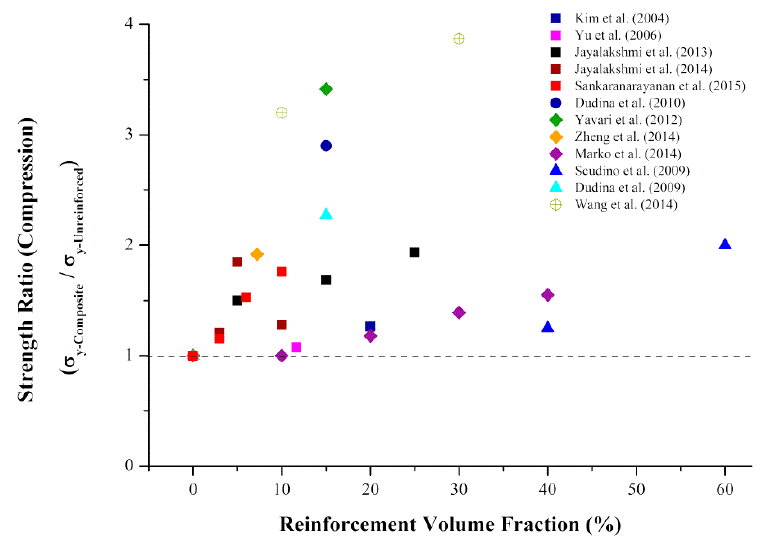
Figure 18. Compressive properties of amorphous alloy/metallic glass reinforced composites produced by different